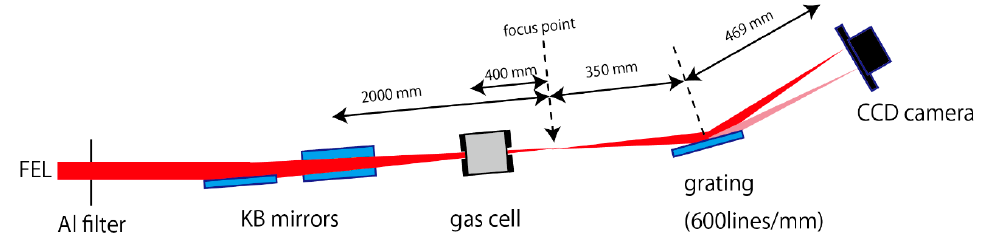
Figure 1. Schematic drawing of the experimental setup for soft X-ray absorption spectroscopy in transmission mode at SACLA BL1.